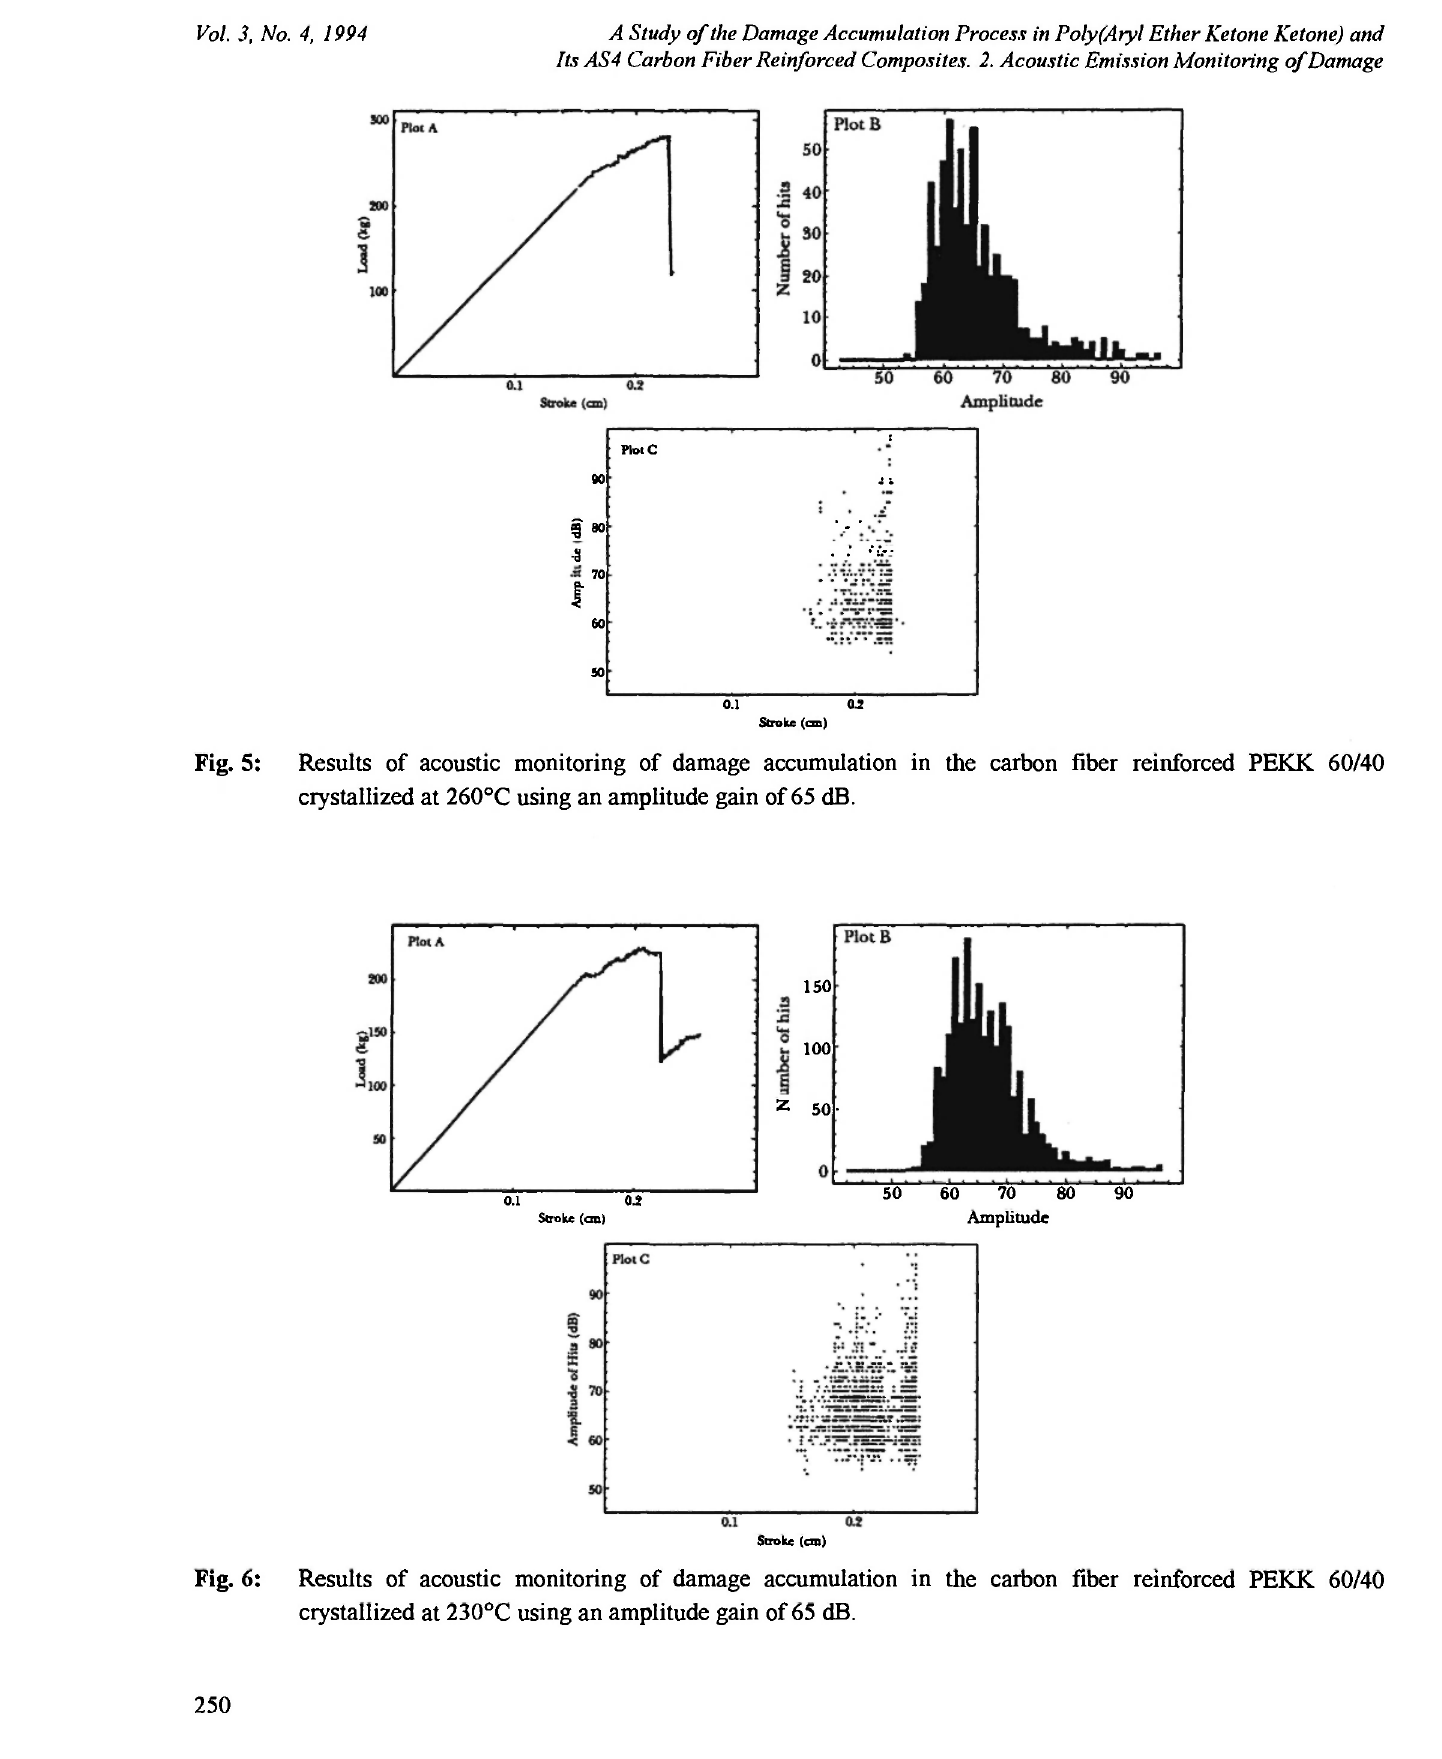
Fig. 6: Results of acoustic monitoring of damage accumulation in the carbon fiber reinforced PEKK 60/40 crystallized at 230°C using an amplitude gain of 65